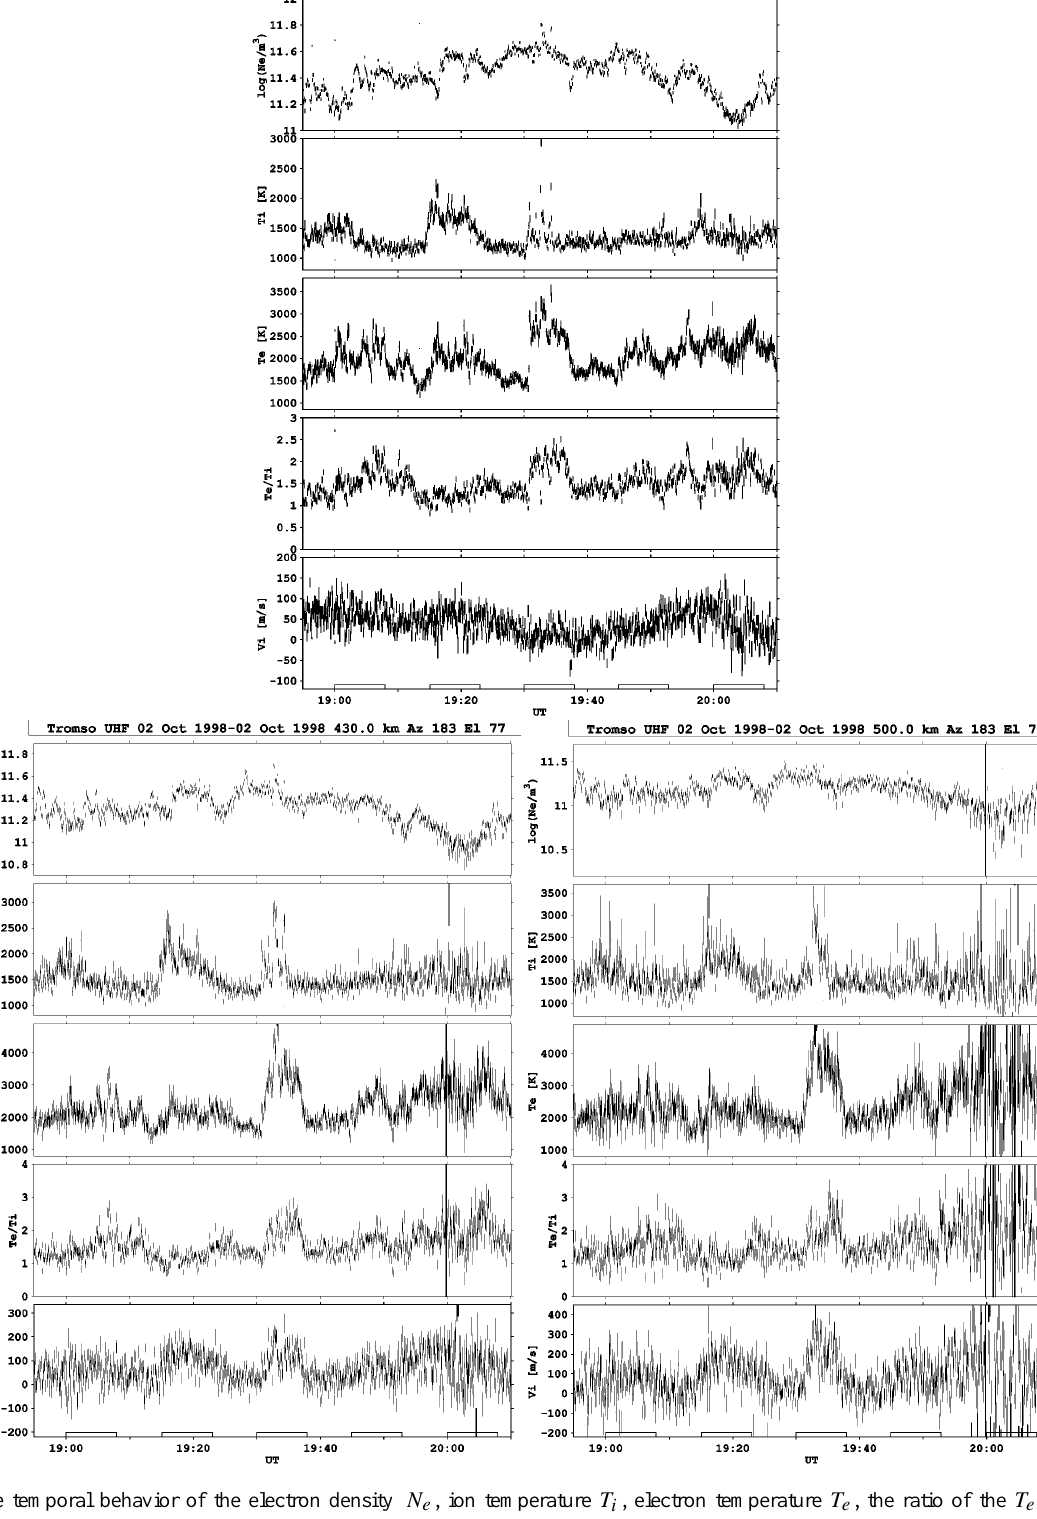
Fig. 6. The temporal behavior of the electron density N e , ion temperature T i , electron temperature T e , the ratio of the T e / T i , and ion velocities V i as observed with the Tromsø EISCAT UHF incoherent scatter radar in the field-aligned direction on 2 October 1998, from 18:56 to 20:10 UT at altitudes of 300, 430, and 500km. EISCAT UHF radar data are obtained by using the long-pulse and analyzed with 20-s integration time. The intervals when the Tromsø HF heating facility was operated are marked by bars on the time axis. The Tromsø HF heating facility was operated with a 8-min on, 7-min off pump cycle (4-min 50% full power, 4-min 100% power then 7-min off).